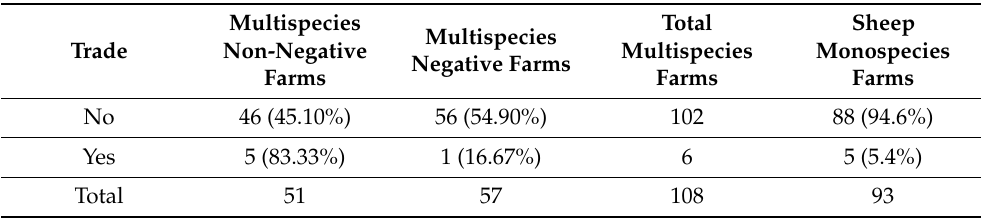
Table 7. Risk factor 3: Results of the association between import history and type of